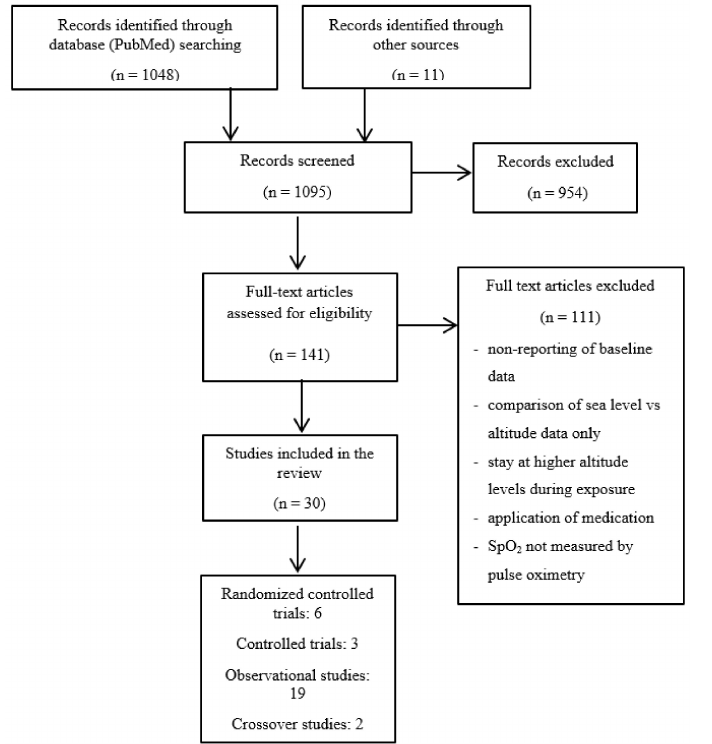
Figure 1. Flow chart of the study selection